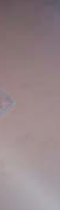
Fig.12. Measurement setup for the proposed antenna over